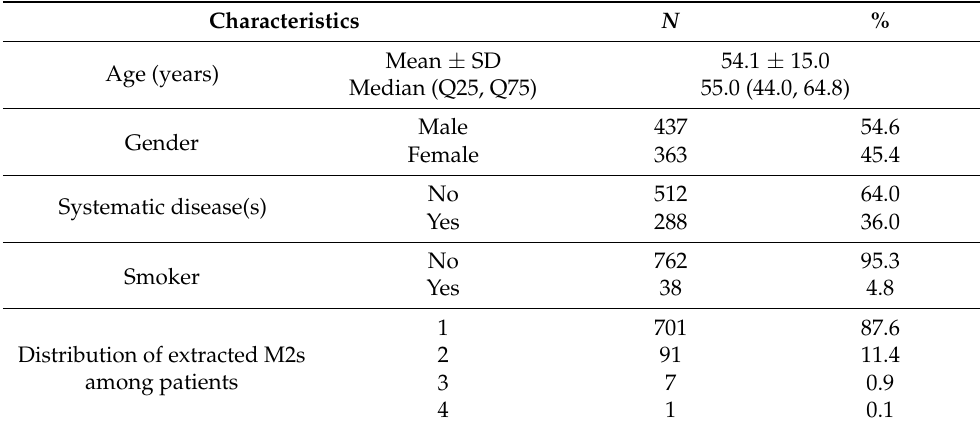
Table 1. Characteristics of the patients whose clinical material was utilized for analysis ( N = 800).